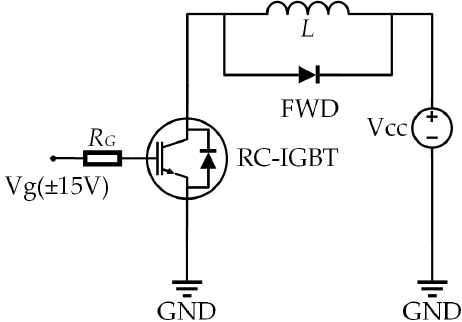
Figure 9. Inductive load circuit for the switching simulation of RC-IGBT.